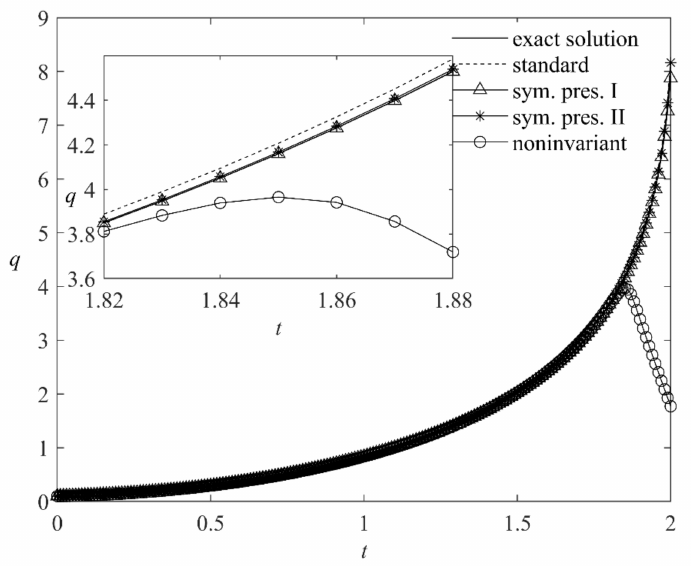
Figure 1. Solutions for the symmetry preserving schemes (49) (sym. pres. I) and (50) (sym. pres. II), the noninvariant (48), the standard RK45 and the exact solution of Hamiltonian